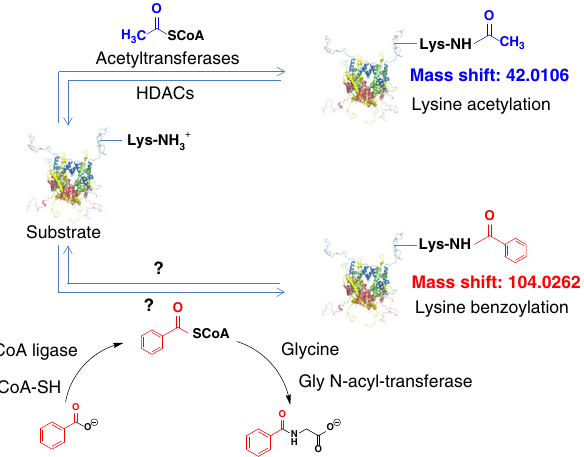
Fig. 1 Lysine acetylation and benzoylation. Chemical structure of K bz that induces a mass shift of + 104.0268Da is shown